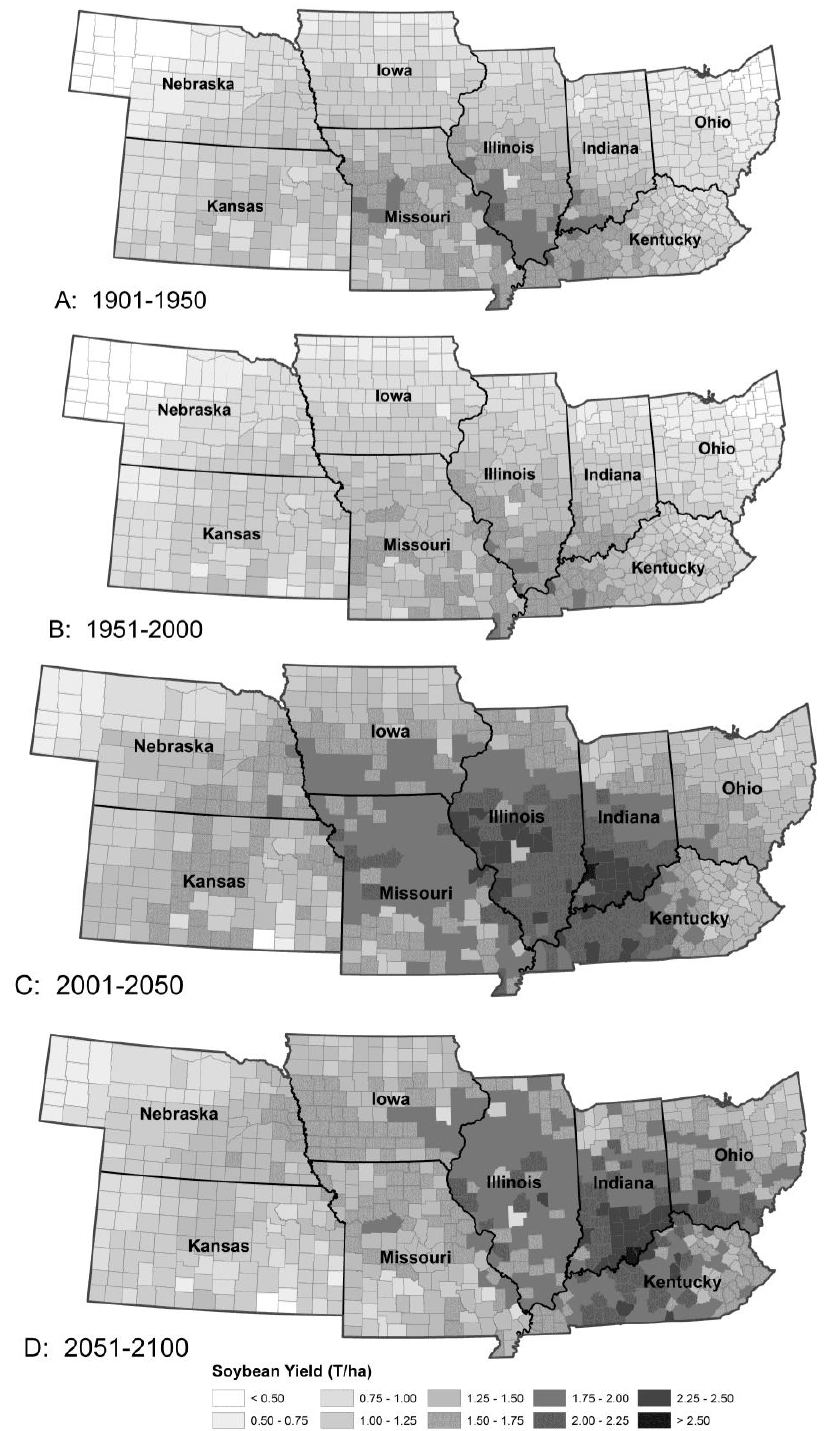
Figure 2. Model predictions for soybean production in the absence of pest pressure: Period 1 ( A ), Period 2 ( B ), Period 3 ( C ) and Period 4 ( D ). The model predicted increasing temperatures from